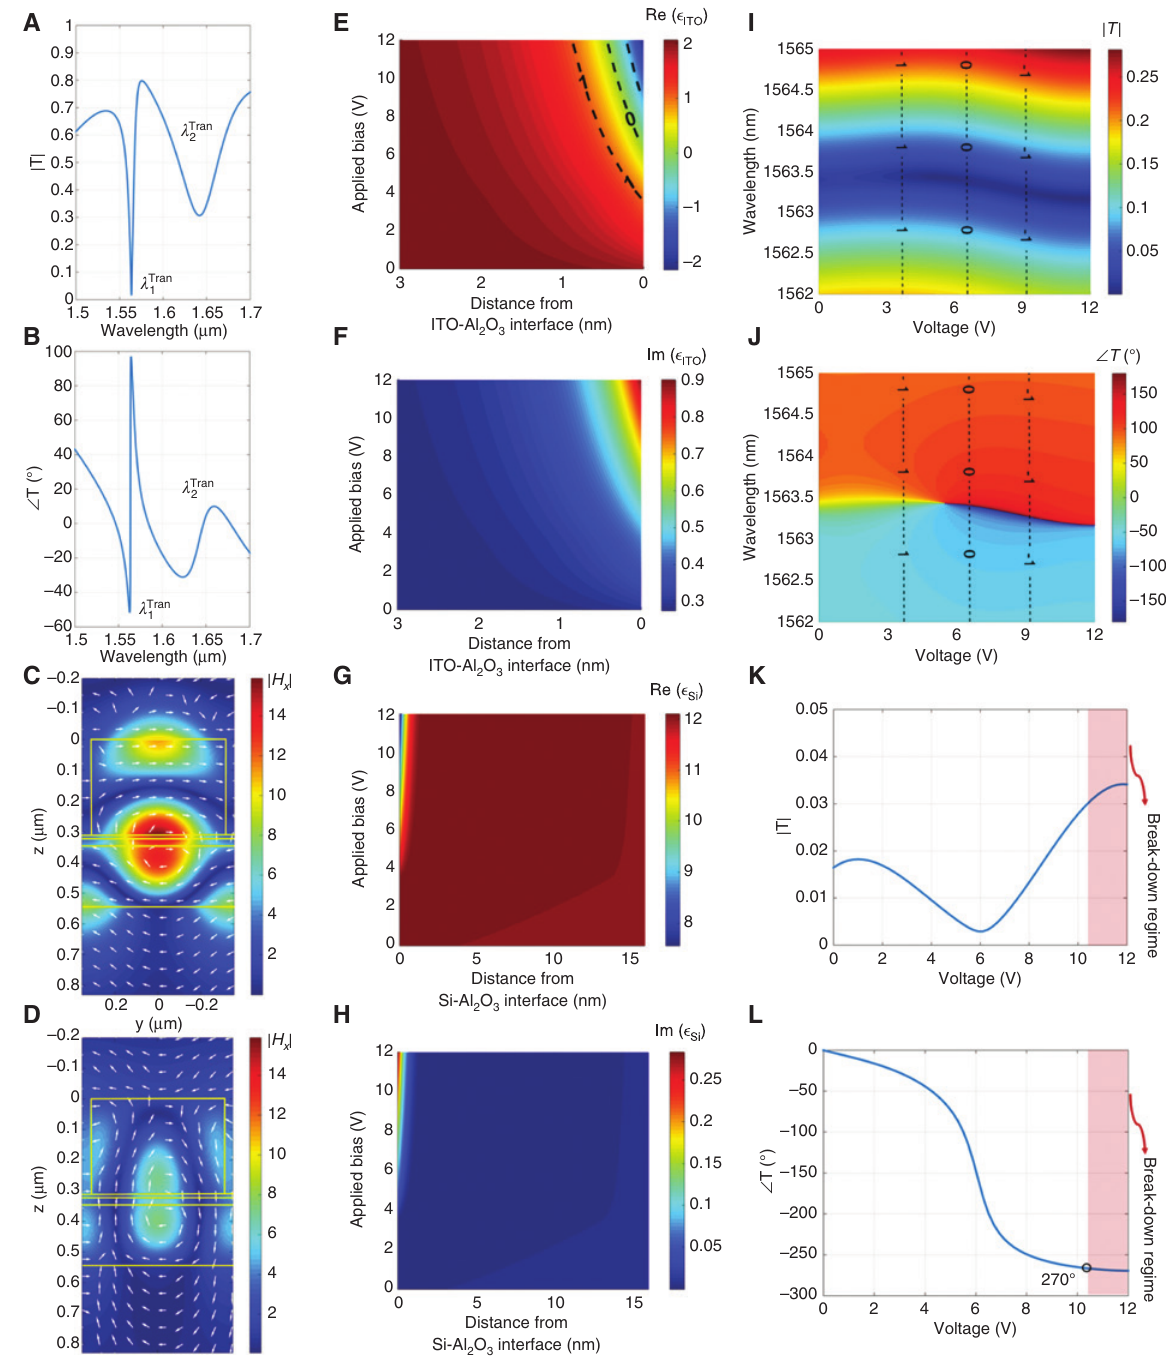
Figure 3: Optical performance of the dual-mode ITO-integrated metasurface unit cell in transmission mode. Transmission (A) amplitude and (B) phase as a function of wavelength for the unbiased case. The near-field distributions of tunable ITO- loaded SIS unit cell at (C) λ 1Tran ≈ 1563 nm and (D) λ 2Tran = 1641 nm corresponding to the excited geometrical resonances. The color bar shows the normal component of the magnetic field (| H |), and the white arrows are related to the normalized electric displacement currents at the x y - z plane. (E–H) The real and imaginary parts of ITO and Si permittivities within their corresponding active layers at an operating wavelength of 1563 nm as functions of applied bias voltage and distance from their interfaces with Al O . The region denoted by dashed lines in (E) 2 3 corresponds to the ENZ region within the ITO active layer. Transmission (I) amplitude and (J) phase as functions of wavelength and various bias voltages from 0 to 12 V. The dashed lines denote the points for which the real part of ITO permittivity, Re{ ε }, at the ITO-Al O interface ITO 2 3 is equal to −1, 0, and 1. (K, L) The transmission amplitude and phase at an operating wavelength of ≈ 1563 nm versus the external DC bias voltage with consideration of the inhomogeneous active layers of ITO and